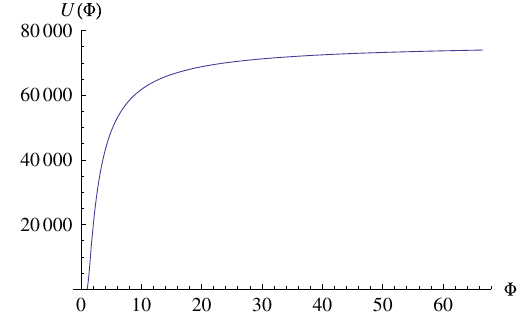
Fig. 5 The diagram presents the typical behaviour of the function ¯ U (Φ) for the case f ( ˆ R ) = ˆ R + γ ˆ R 2 . The potential ¯ U (Φ) is expressed . Note that, for the large value of Φ , the function ¯ U (Φ) has in km 2 s 2 Mpc 2 the plateau